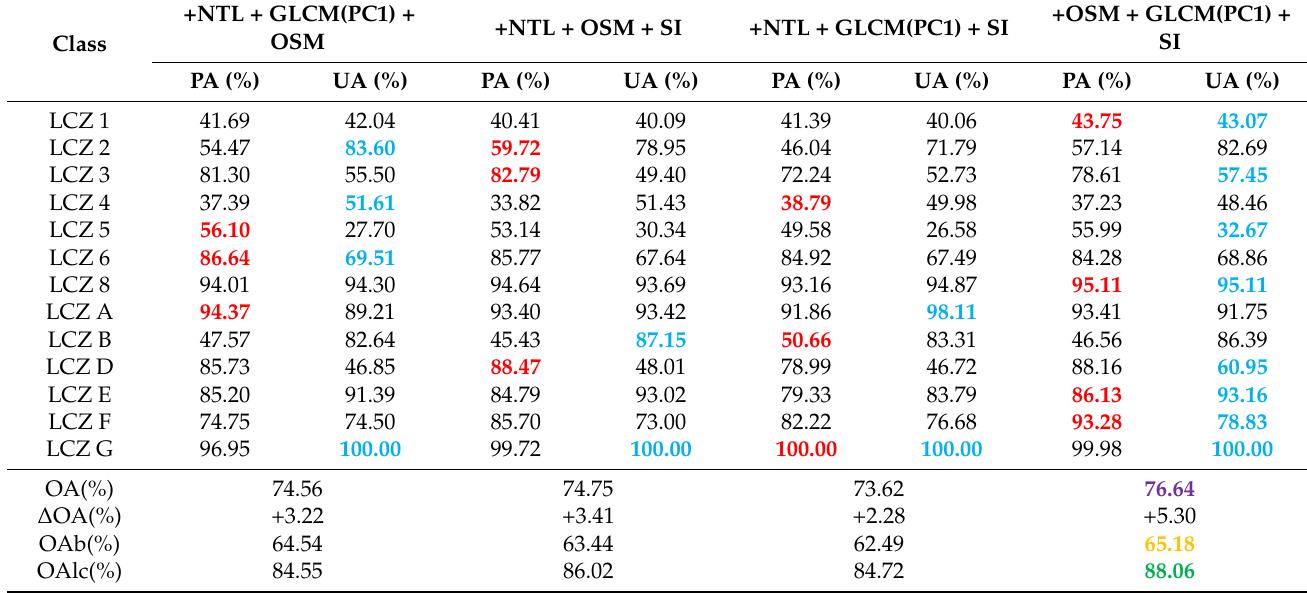
Table 8. The accuracy comparison of adding any three secondary datasets to the basic